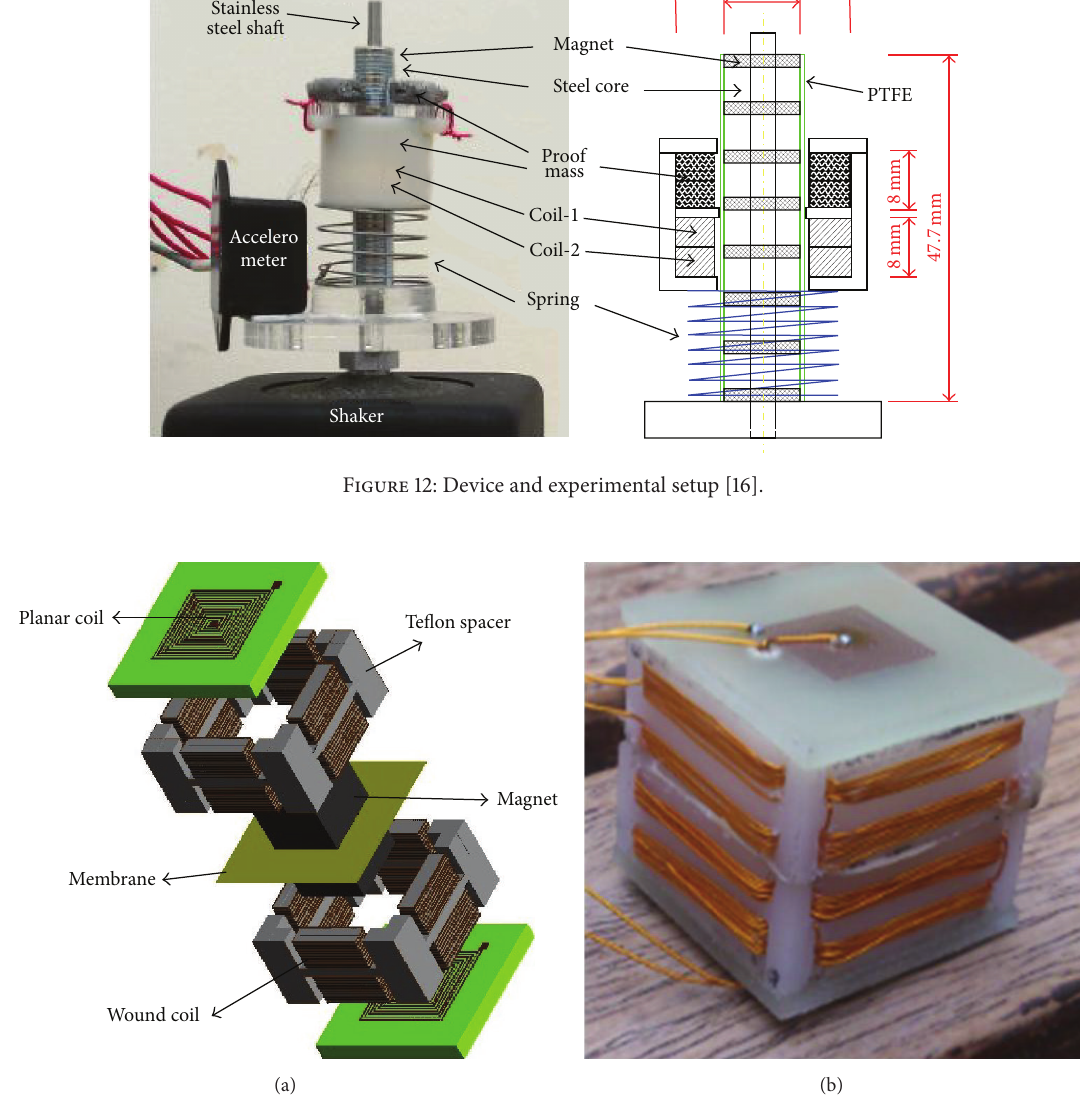
Figure 13: EM-VEH developed in [37]: (a) exploded view and (b) assembled